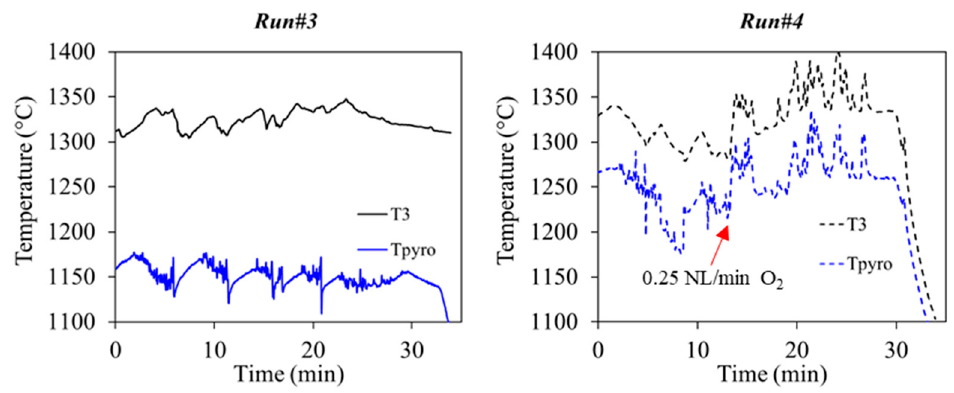
Figure 9. Reactor temperatures in Run#3 (solar-only) and Run#4 (both solar and solar-hybrid).